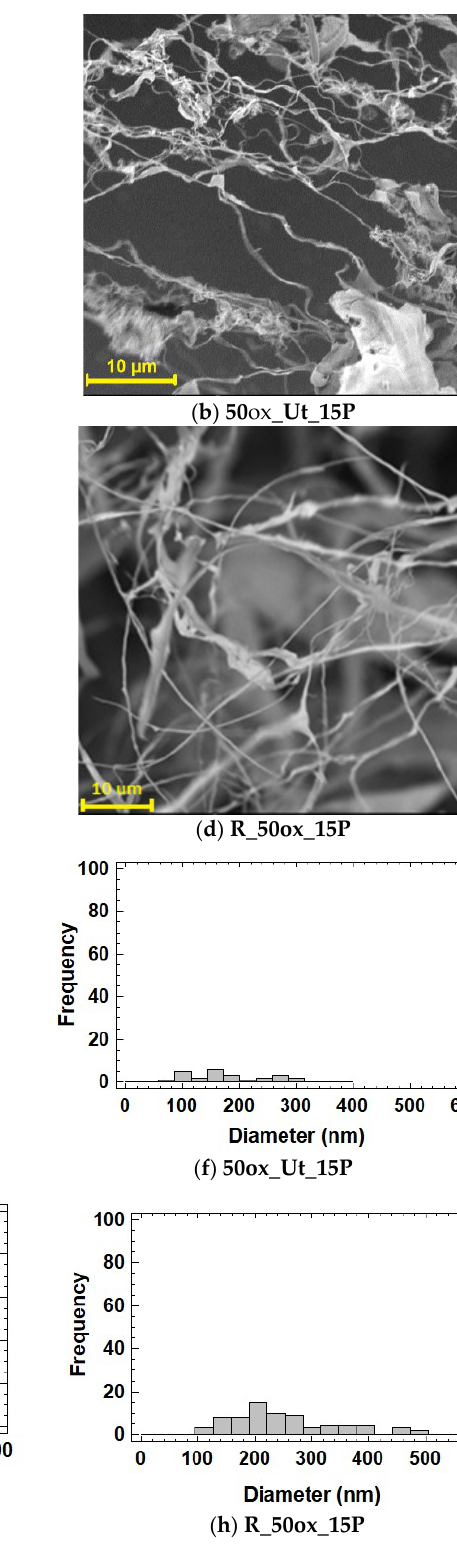
Figure 3. SEM images of ( a ) 25ox_Ut_5P, ( b ) 50ox_Ut_15P, ( c ) R_25ox_5P and ( d ) R_50ox_15P of CMNF. Distribution of diameter ( e–h ).